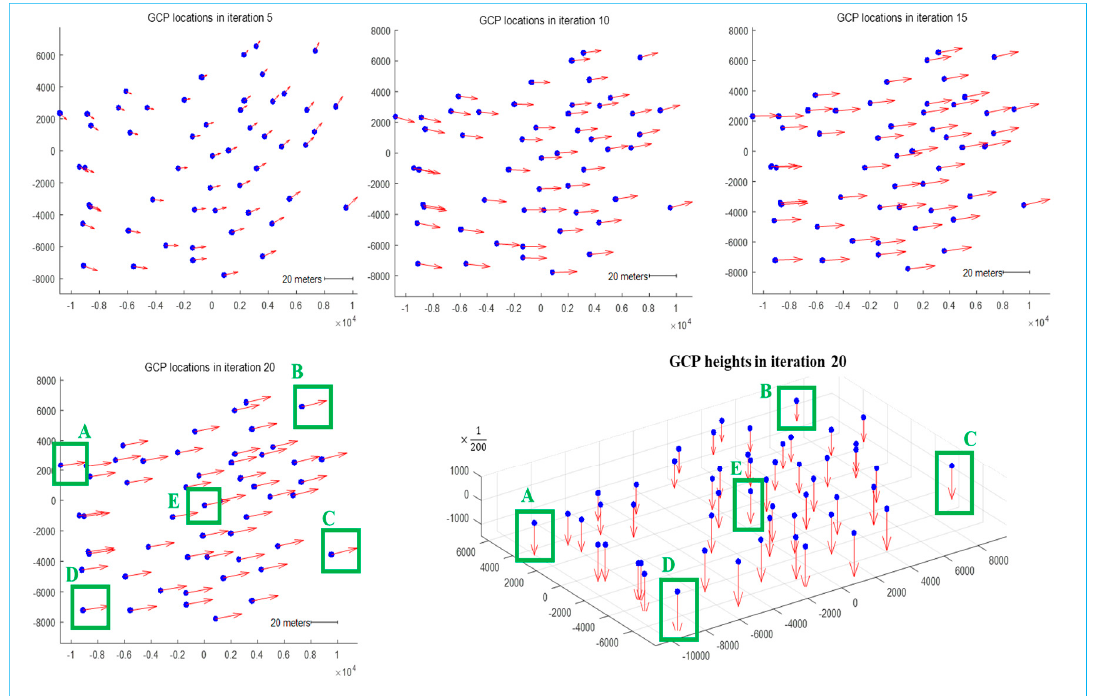
Figure 11. The iteration behaviour related to the transformed GCPs. Visualised is the vector field (𝒑 (cid:3036)∗ (cid:3398) 𝒑 (cid:3036) ) ∀ 𝑖 (cid:3404) 1,𝑁 for selected iterations (the unit of the axes is meters). The transformation sequence over 20 iterations is illustrated in Figure 12 exemplarily for five GCPs marked by the green border in Figure 11. Four GCPs were selected which are close to the respective corners of the project area as well as one GCP which is located in the middle. The left column in Figure 12 shows the horizontal movement of the points over all iteration steps. In the right column, the vertical movement is visualized in a 3D view. The movement of GCPs B and E over all iteration steps appear remarkably smooth, which is particularly visible in the 2D plot (left column of Figure 12). Essentially, a smooth movement pattern can also be observed with the other three GCPs, although the 2D track appears more curved. With all GCPs, large movements of the points occur, more or less, during the first 15 iteration steps. The incremental displacements then become smaller and smaller until they are virtually zero after 18 iterations. As expected, the movement of the GCP correlates with the convergence behaviour of the estimated parameters (cf. Figure 8).